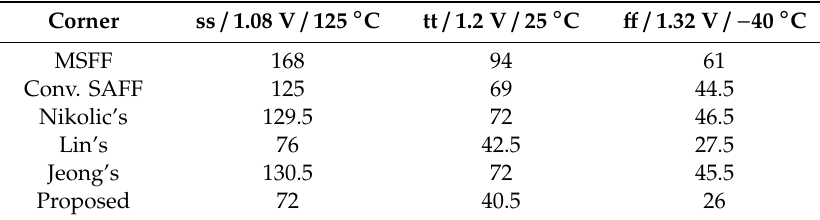
Table 3. CK-to-Q delay (ps) of the flip-flops across PVT corners.